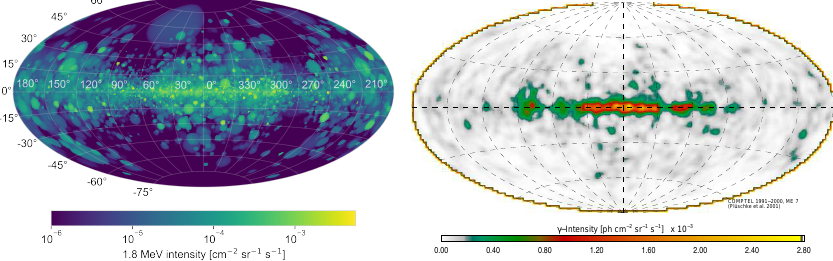
Figure 2. The spatial appearance of the 26 Al sky as predicted from our PSYCO bottom-up massive- Figure 5.21: Best fitting sky map with TS = 2061 (cf. Eq. 5.3) out of 30000 PSYCO models (cf. Fig. 5.19). It is based on GM00 with 700 pc scale height and SFR = 8 M  yr  1 , IMF K01, stellar models LC06, and explodability LC18. cluster model ( left ) is similar to the COMPTEL 26 Al skymap ( right ). Note that the model image is plotted over a larger dynamic range of intensities, compared to the COMPTEL